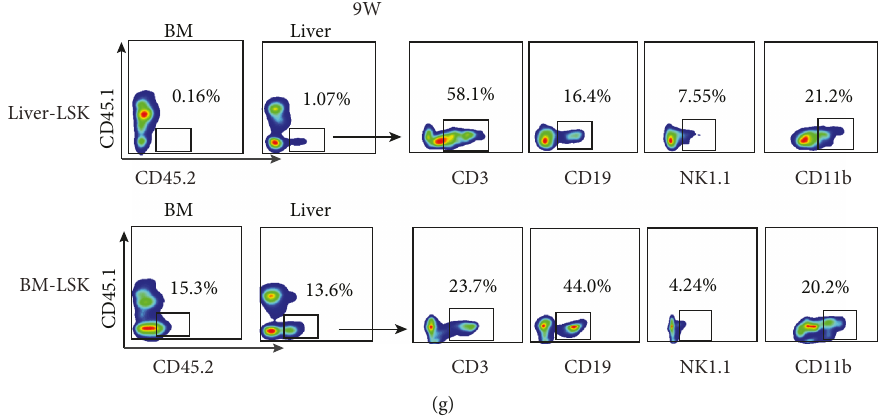
Figure 2: The ability of adult liver LSK cells to di ff erentiate into lymphocytes and myeloid cells in vivo. (a, c, e) 2 × 10 4 liver or BM LSK cells obtained from CD45.2 mice were mixed with 2 × 10 5 unfractionated CD45.1 + competitor bone marrow cells and intravenously injected into lethally irradiated CD45.1 recipient mice. Peripheral blood was collected weekly. The proportion of di ff erentiated lymphoid (CD3 + , CD19 + , and NK1.1 + ) and myeloid (CD11b + ) lineages of CD45.2 + cells in the peripheral blood of CD45.1 + recipient mice was detected by FACS at weeks 3, 6, and 9. The experiments were repeated three times. (b, d, f) Statistical chart of the proportion of CD3 + T, CD19 + B, NK1.1 + NK, and CD11b + myeloid cells derived from CD45.2 + donor cells in the peripheral blood of CD45.1 + recipient mice at weeks 3, 6, and 9 ( n = 3 ). Bars represent the mean ± SEM of three independent experiments. ∗ P < 0 05 . (g) Flow cytometric plots show the percentages of CD45.2 + cells in the liver of CD45.1 + recipient mice detected by FACS at the 9 th week. The proportions of di ff erentiated lymphoid (CD3 + , CD19 + , and NK1.1 + ) and myeloid (CD11b + ) lineages of CD45.2 + cells in the liver of CD45.1 + recipient mice were detected by